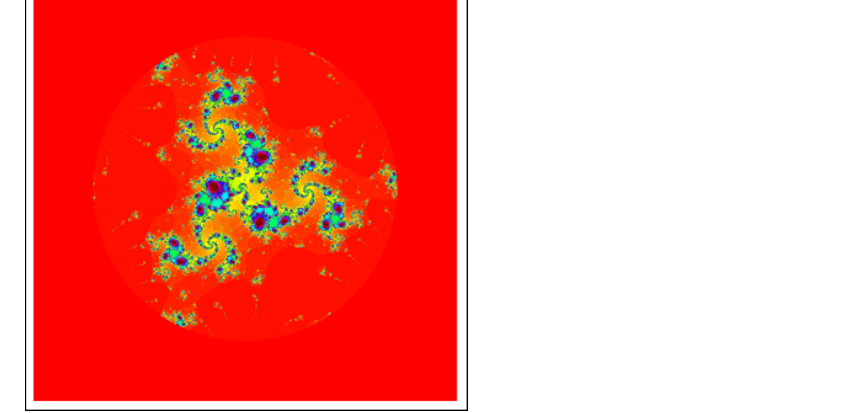
Figure 18. J-set via F-iterative process for sin ( z 3 ) + 0.51 with image visual time = 46.5 s.